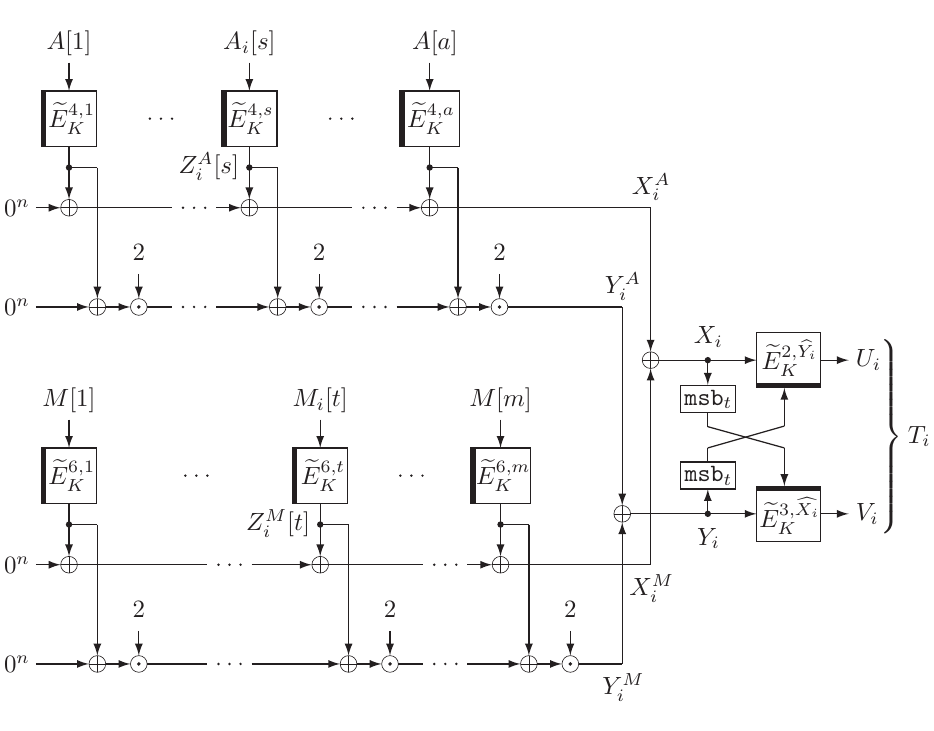
Figure 9: Our attack against SIVx. a and m can be different, and this figure assumes | A [ a ] | = | M [ m ] | = n . A i [ s ] = M i [ t ] = h i i , and all other blocks are fixed. s and t are chosen to satisfy a − s = m − t